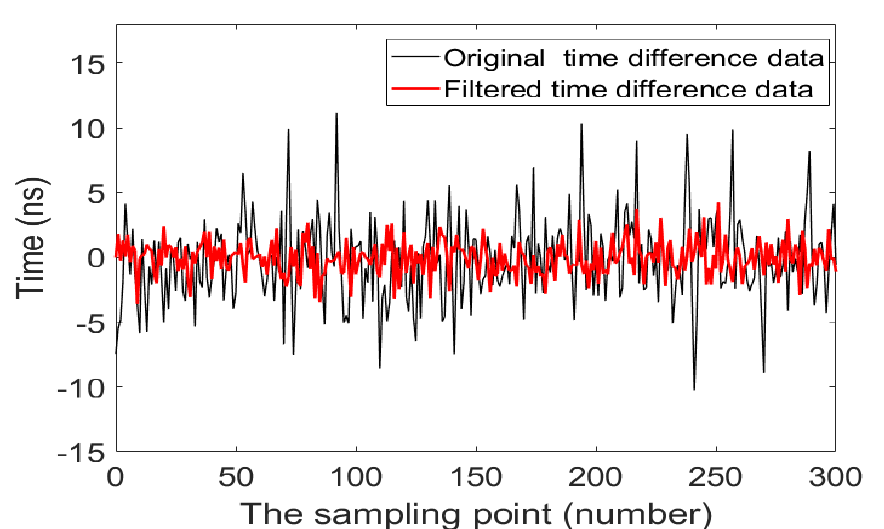
Figure 10. Comparison of zero-drift before and after data filtering.